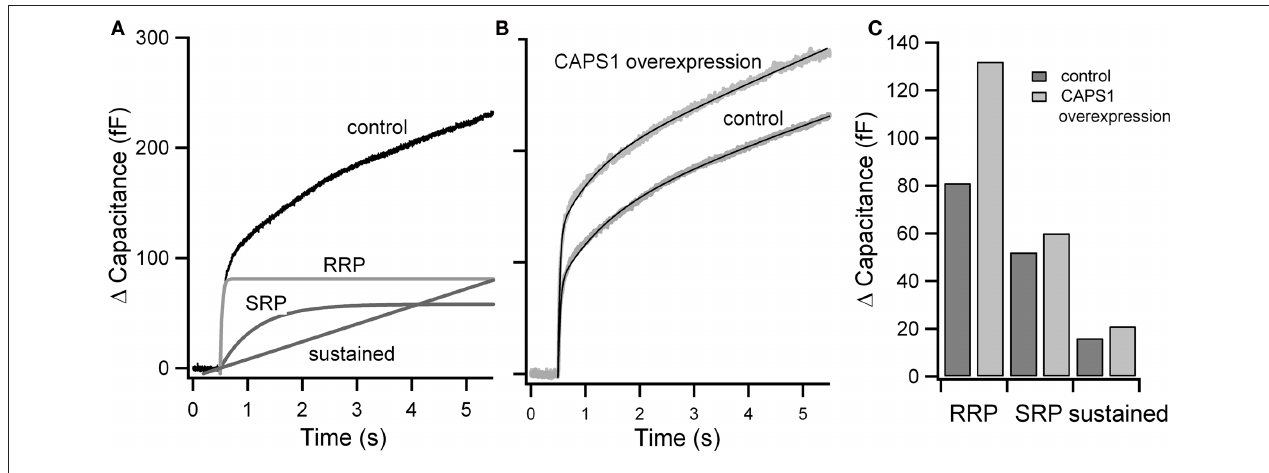
exponentials and a linear phase are shown. (B) Example experimental application: flash responses and fits (black) of control cells and cells overexpressing CAPS1 (data from Liu et al., 2008). (C) Comparison of the size of RRP, SRP, and sustained component in control and CAPS1 overexpressing